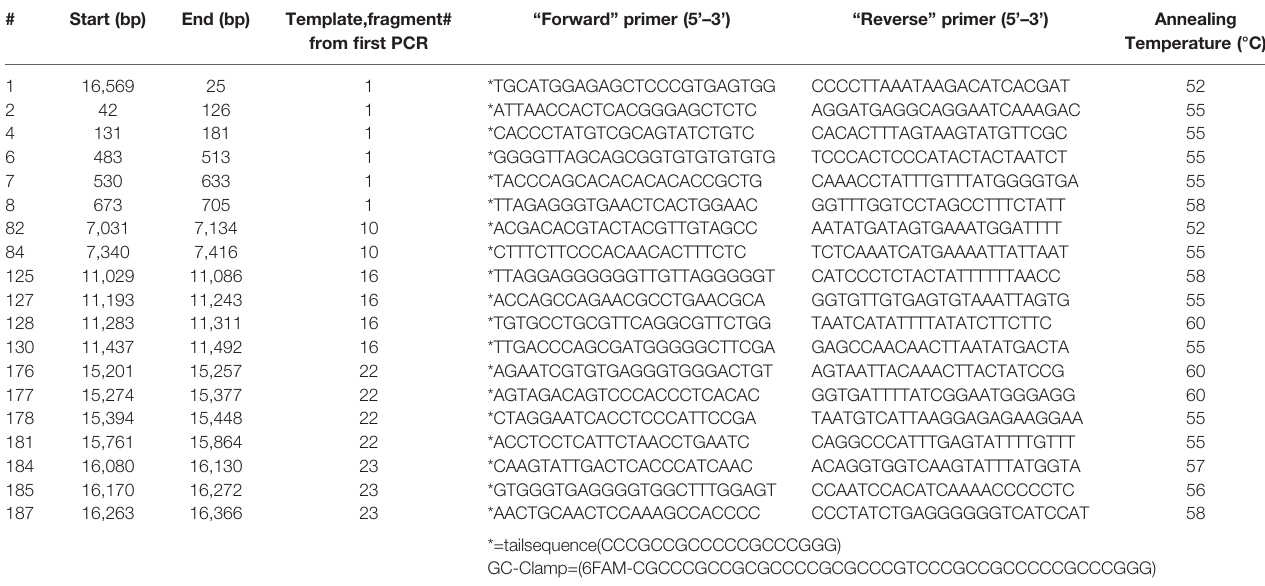
TABLE 2 | Second round primer pairs used in the